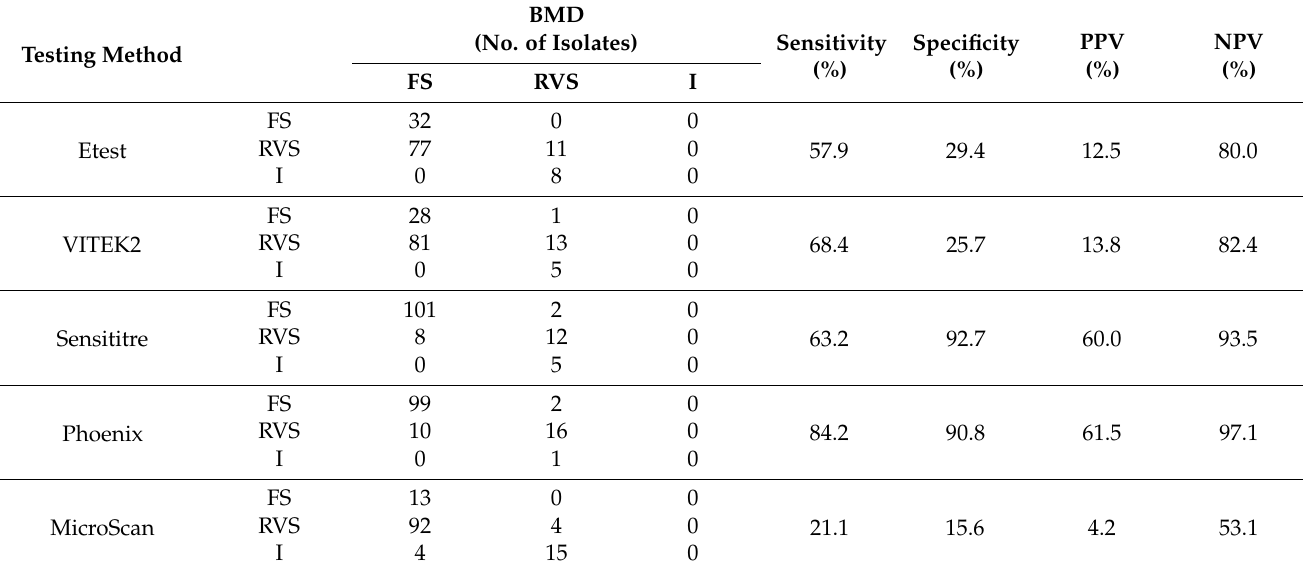
Table 4. The performance for detection of reduced vancomycin susceptibility in S. aureus of different antimicrobial susceptibility testing